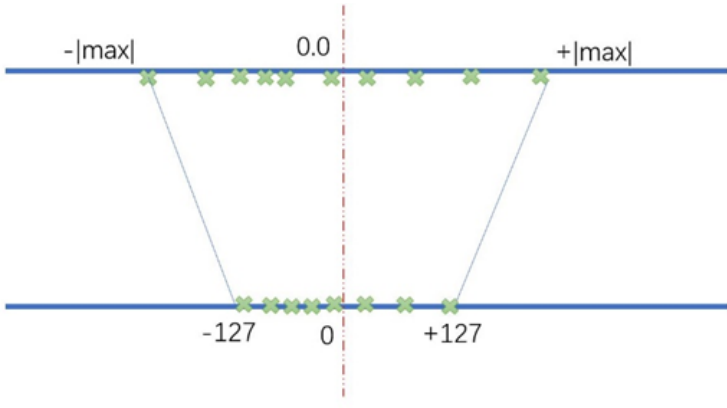
Figure 3. The process of